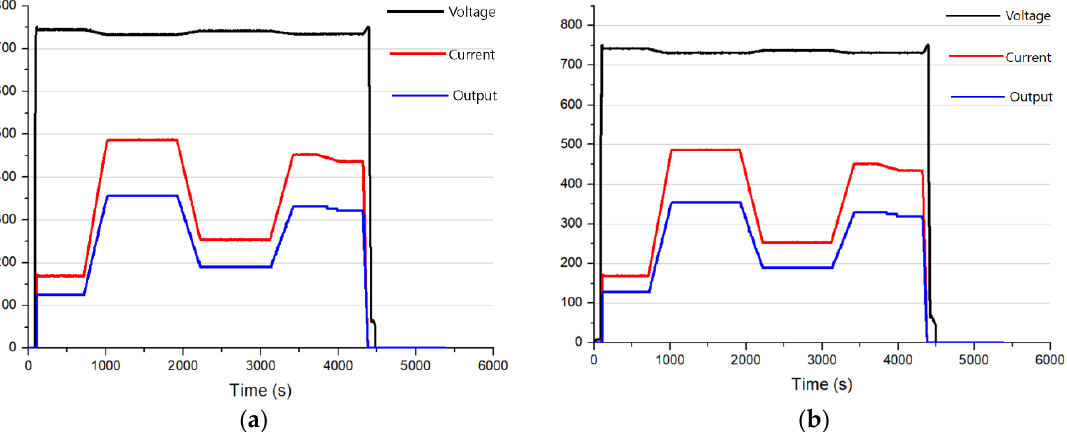
Figure 15. Electric characteristic in voltage, current, and power for the 5500 TEU scenario; ( a ) AC grid system (Constant speed mode), ( b ) DC grid system (Variable speed mode).